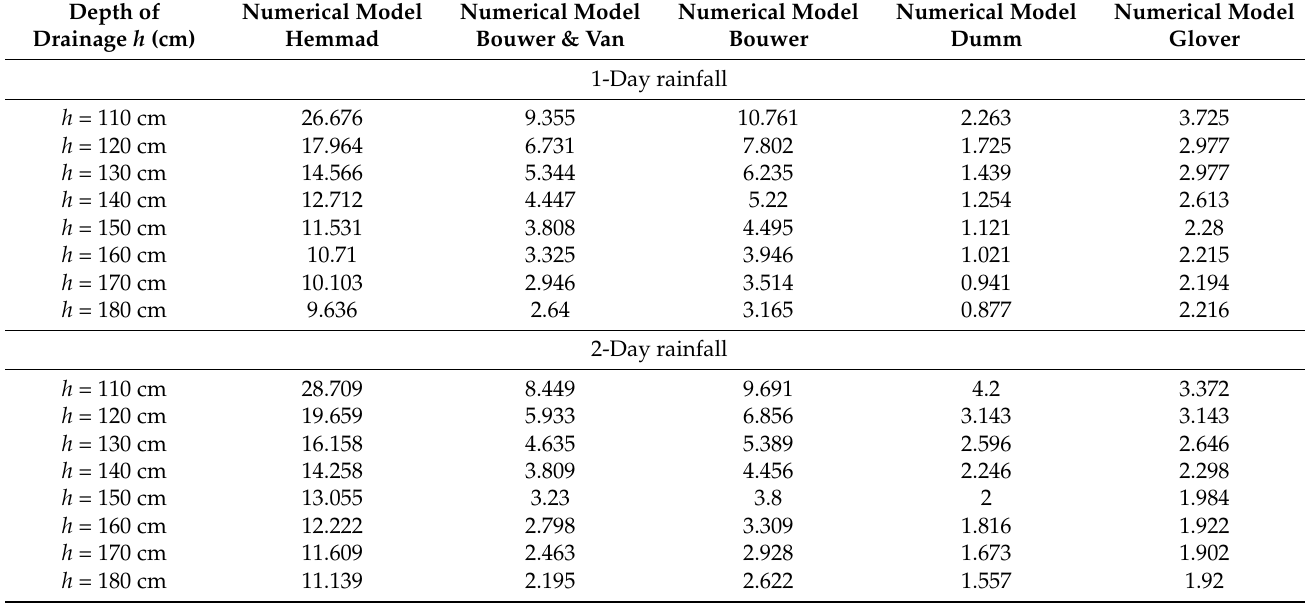
Table 7. Numerical values of reaction modulus ( α ) in numerical models of unsteady conditions and depth install drain h under 1- to 5-day